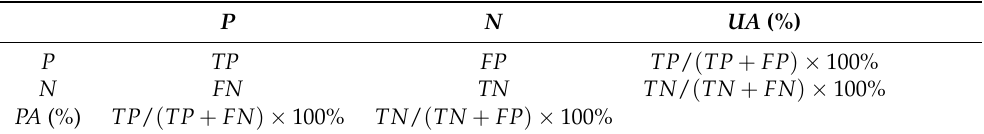
Table 2. The definition of the confusion matrix: P = positive condition; N = negative condition; TP = true positive; FP = false positive; TN = true negative; FN = False Negative; UA = user’s accuracy; PA = producer’s accuracy. The producer’s accuracy refers to the probability that a certain class is classified correctly, and the user’s accuracy refers to the reliability of a certain